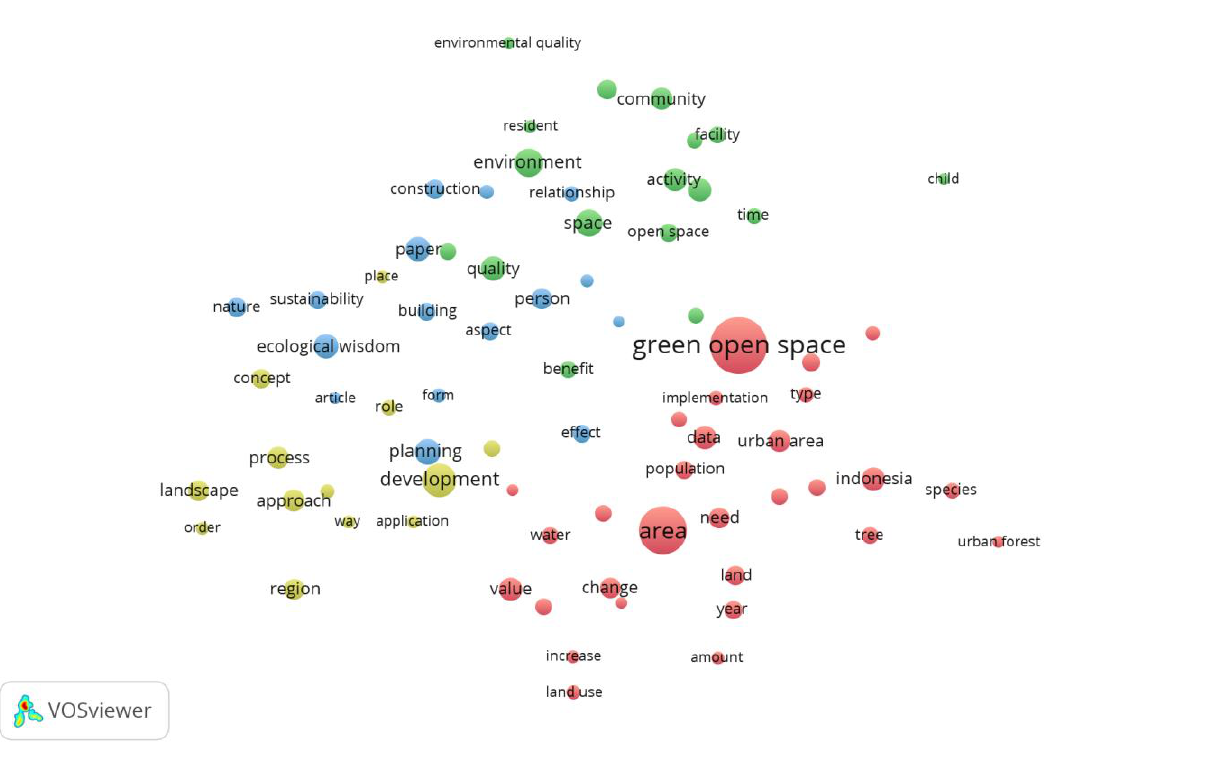
Fig. 4. Co-occurrence map of document collection